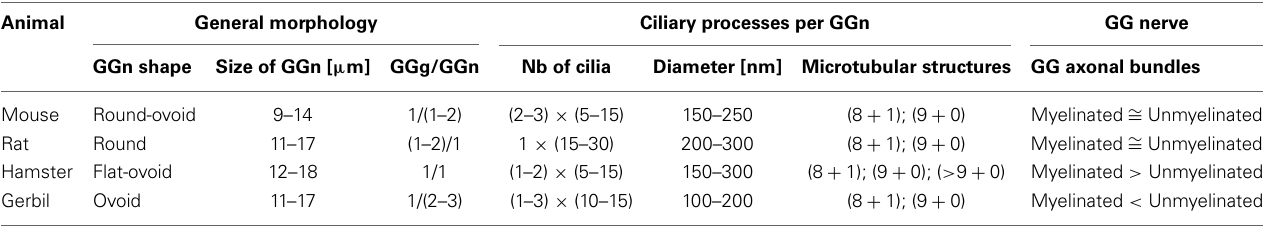
Table 1 | Morphological characteristics of the rodent